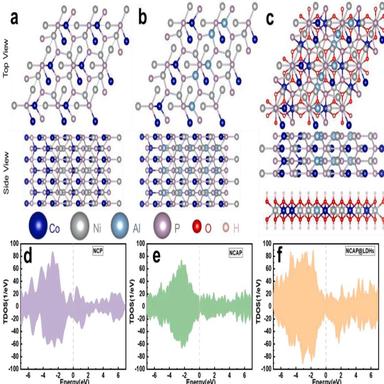
The crystal structure models and the corresponding density of states of NCP (a and d), NCAP (b and e), and NCAP (c and f).